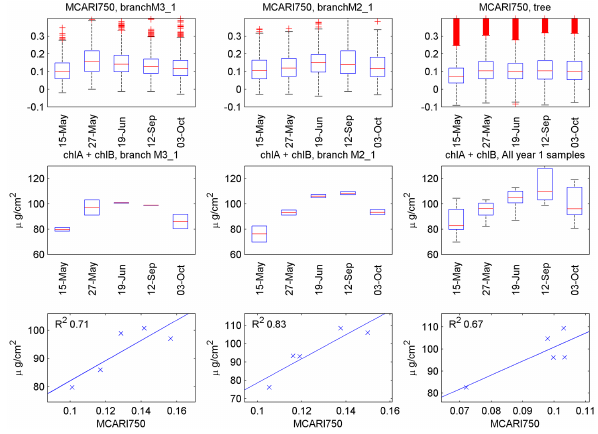
Figure 3. Top row: distribution of MCARI750 spectral index dur- ing separate scans – the central mark is the median, the edges of the box are the 25th and 75th percentiles, and the whiskers extend to the most extreme data points not considered outliers. Middle row: laboratory measurements of chlorophyll a + b content per needle surface area. Bottom row: correlation of the spectral index and lab- oratory measurement. Subplot columns left to right: sample branch 3, year 1; sample branch 2, year 1; and spectral index of whole tree and laboratory measurements of all year 1 samples.